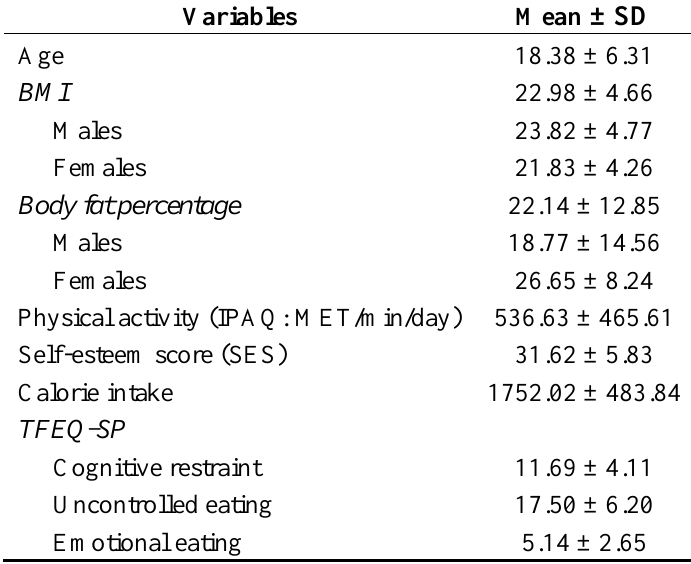
Table 2. Descriptives statistics. Continuous variables ( n = 281). Mean ±